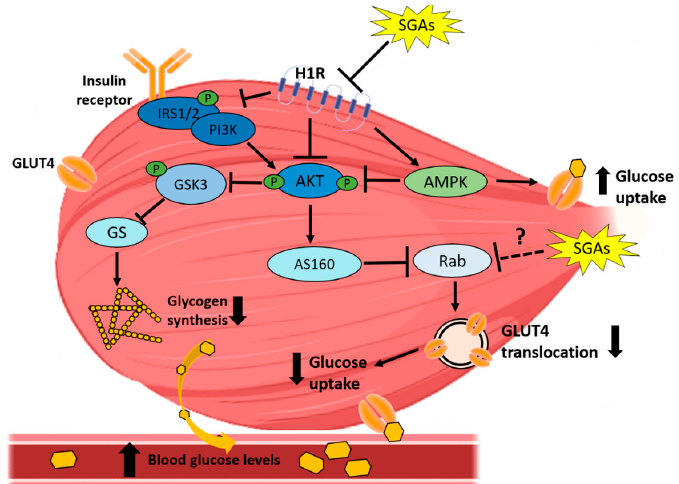
Figure 3. SGA-induced impairment in skeletal muscle insulin signaling and glucose uptake. SGAs